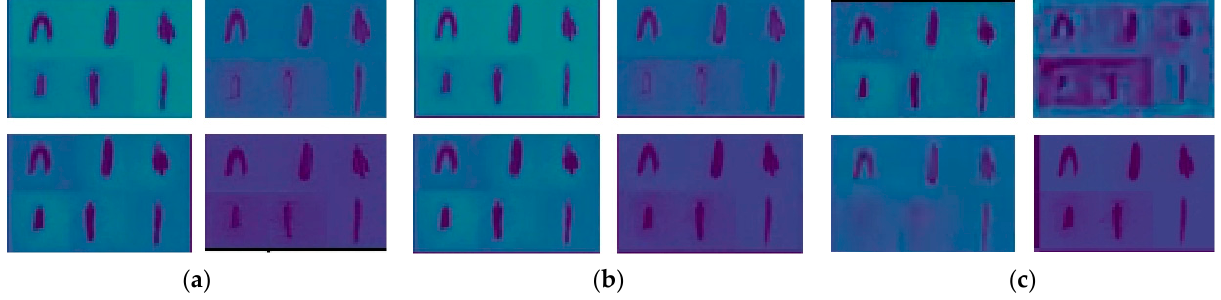
Figure 9. Comparison of loss value reduction of mobile-slimv5s with/without teacher network supervision.